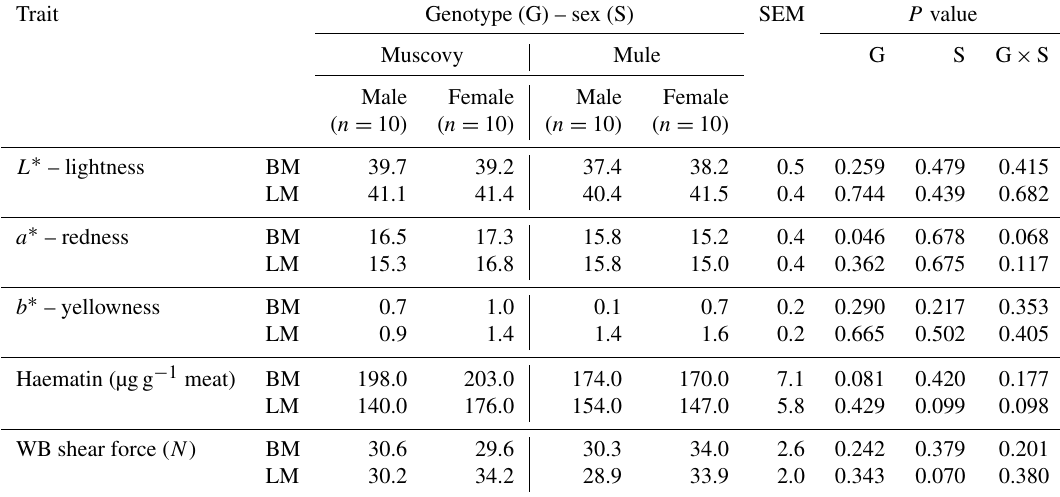
Table 5. Selected physicochemical traits of the breast and leg muscles of ducks of different genotypes.